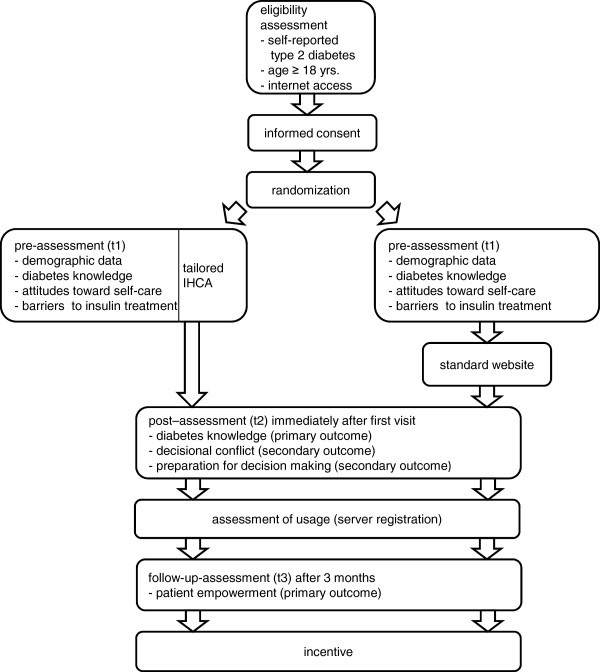
Study procedures.